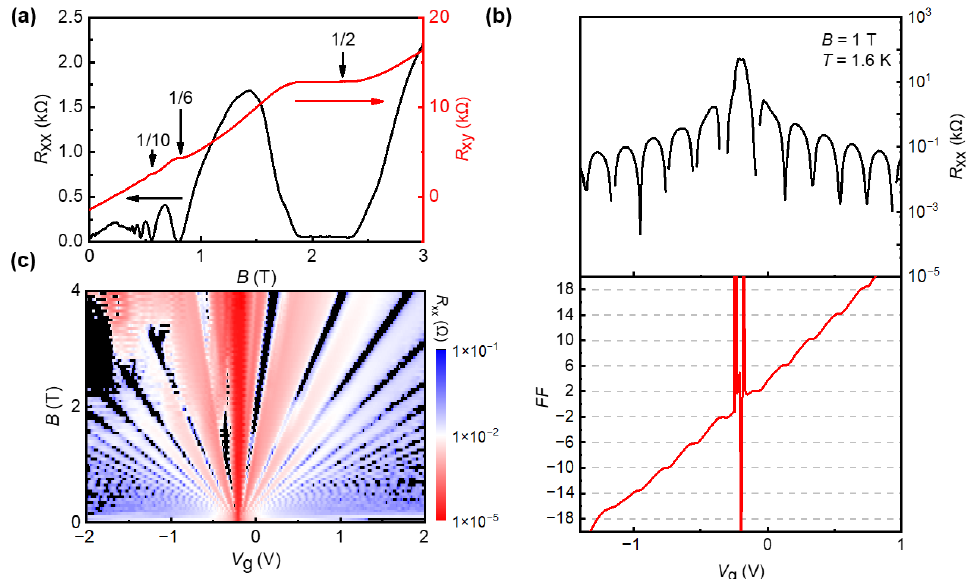
Figure 3. ( a ) Longitudinal resistance R xx and Hall resistance R xy as a function of magnetic field B at V g = 0.5 V and T = 1.6 K. ( b ) Longitudinal resistance R xx (black, top) and filling factor (FF) of R xy (red, bottom) as a function of graphite-gate voltage at T = 1.6 K, B = 1 T. The horizontal dashed gray lines indicate the plateau values of the half-integer QHE. ( c ) False-color map of the longitudinal resistance R xx of this device as a function of graphite-gate voltage ( V g ) and magnetic field ( B ).